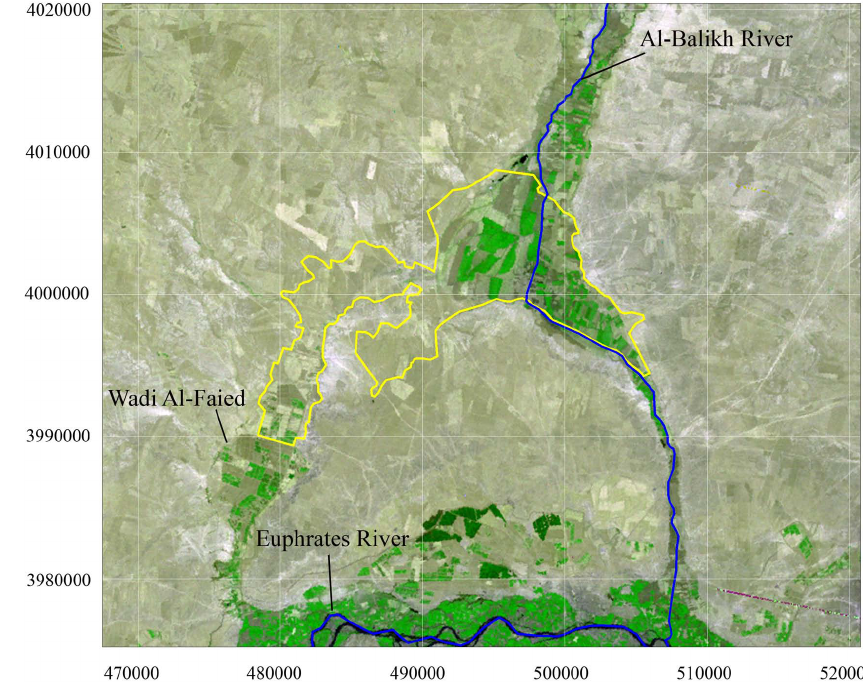
Fig. 4. Landsat2, False Color Composite (Red=band 5; Green=band 6; Blue=band 4), 8 August 1975, 09:34LT.